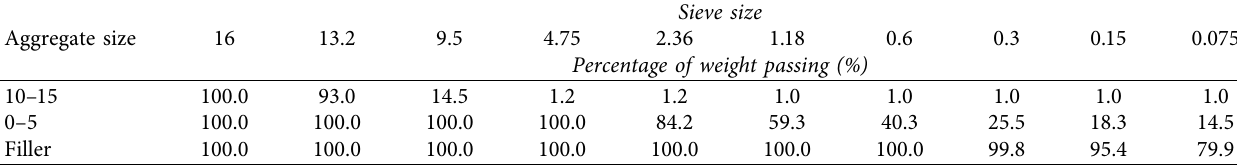
Table 5: Aggregate sieving analysis.